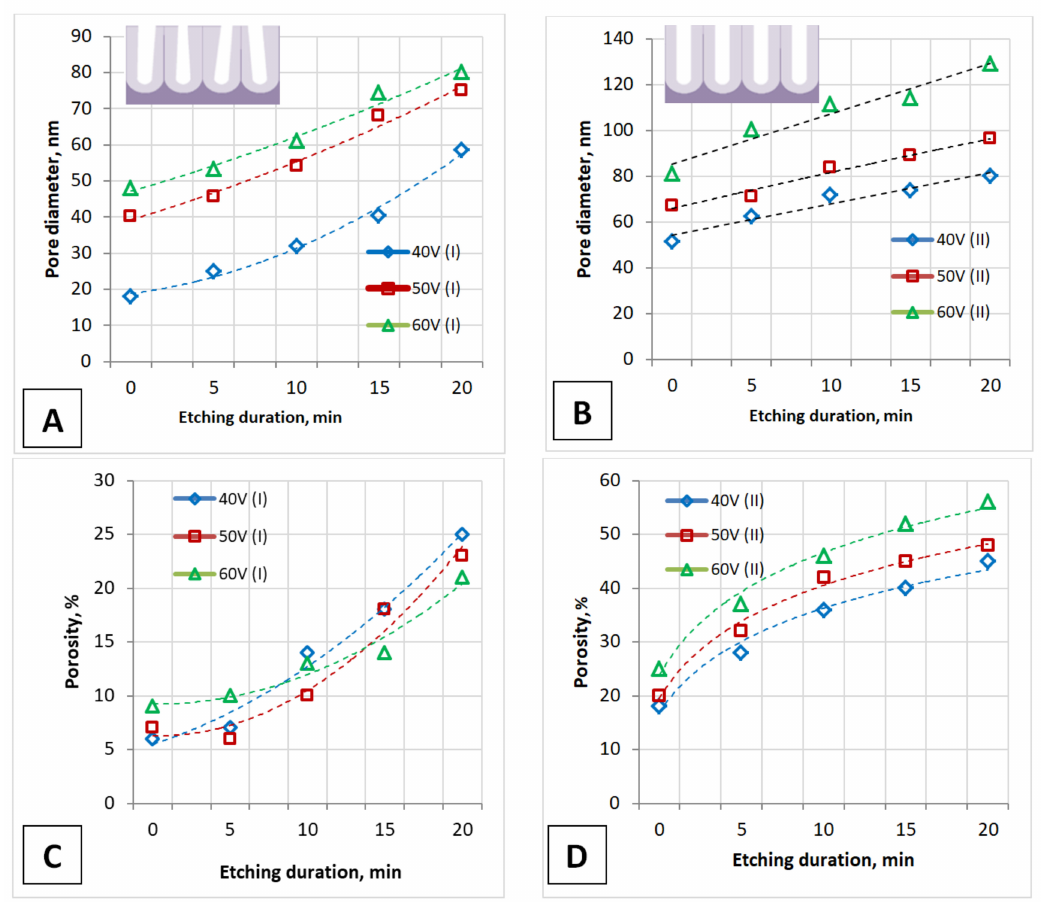
Figure 4. The influence of the main parameters of PAA obtaining (anodizing voltage and etching duration of the barrier layer) on the pore diameter of PAA during one-stage ( A ) and two-stage ( B ) anodizing and on the PAA porosity during one-stage ( C ) and two-stage ( D ) anodizing. The insets schematically show the cross-section of one-stage ( A , C ) and two-stage ( B , D ) anodized PAA